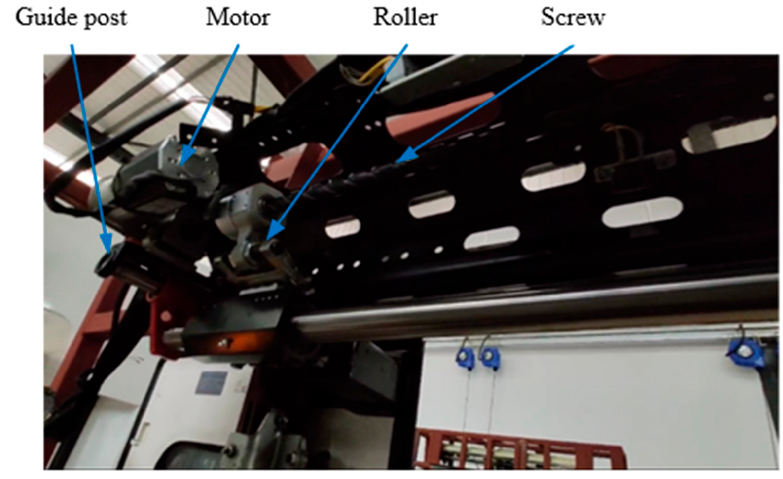
Figure 6. Physical drawing of sliding door transmission system.